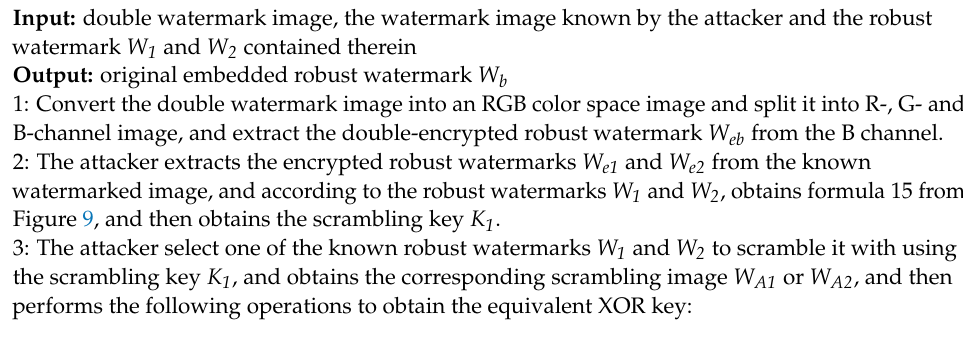
Algorithm 5: Extracting Robust Watermark W